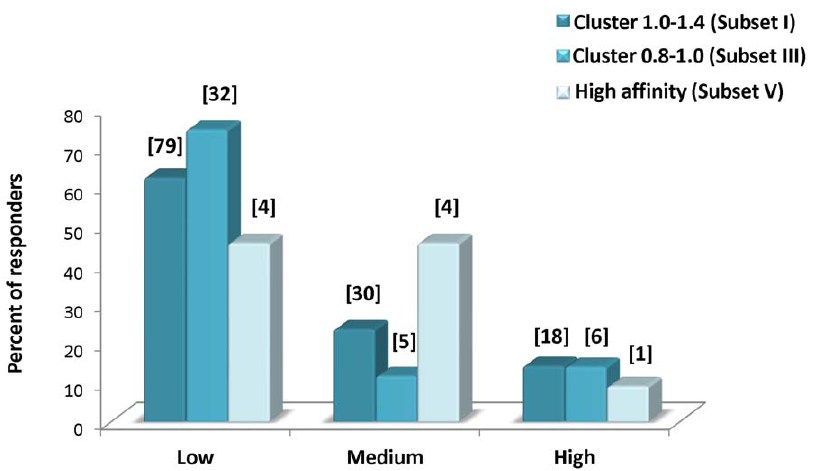
Figure 3. Magnitude of T-cell response among identified CTL epitopes (Subsets I, III, V). Responders identified from clusters with densities of 1.0–1.4 (dark cyan) (determined from [14]), from clusters with densities of 0.8–1.0 (light cyan) and from the high affinity-based approach (light blue) are classified according to magnitude of T-cell response, as deduced from number of spots in the EliSpot assay. The bars represent the percent of responders per subset in each of the classes, while the actual number of responders is given in brackets on the top of the corresponding bar. Classification (expressed in number of spots/million cells) is: Low: 5–20; Medium: 20–32; High . =33).